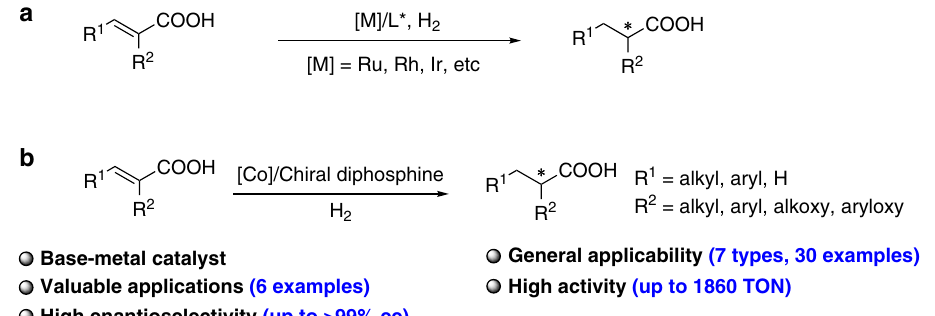
Fig. 1 Biologically active compounds and drugs derived from chiral carboxylic acid. Ibuprofen and Naproxen (nonsteroidal anti-in fl ammatory drugs); ( R )- Tiagabine ( γ -aminobutyric acid reuptake inhibitor); Artemisinin (antimalarial drug); Rupintrivir (rhinovirus protease inhibitor); ( S )-Equol (soy iso fl avonoid metabolite); Sacubitril (antihypertensive drug used in combination with Valsartan).